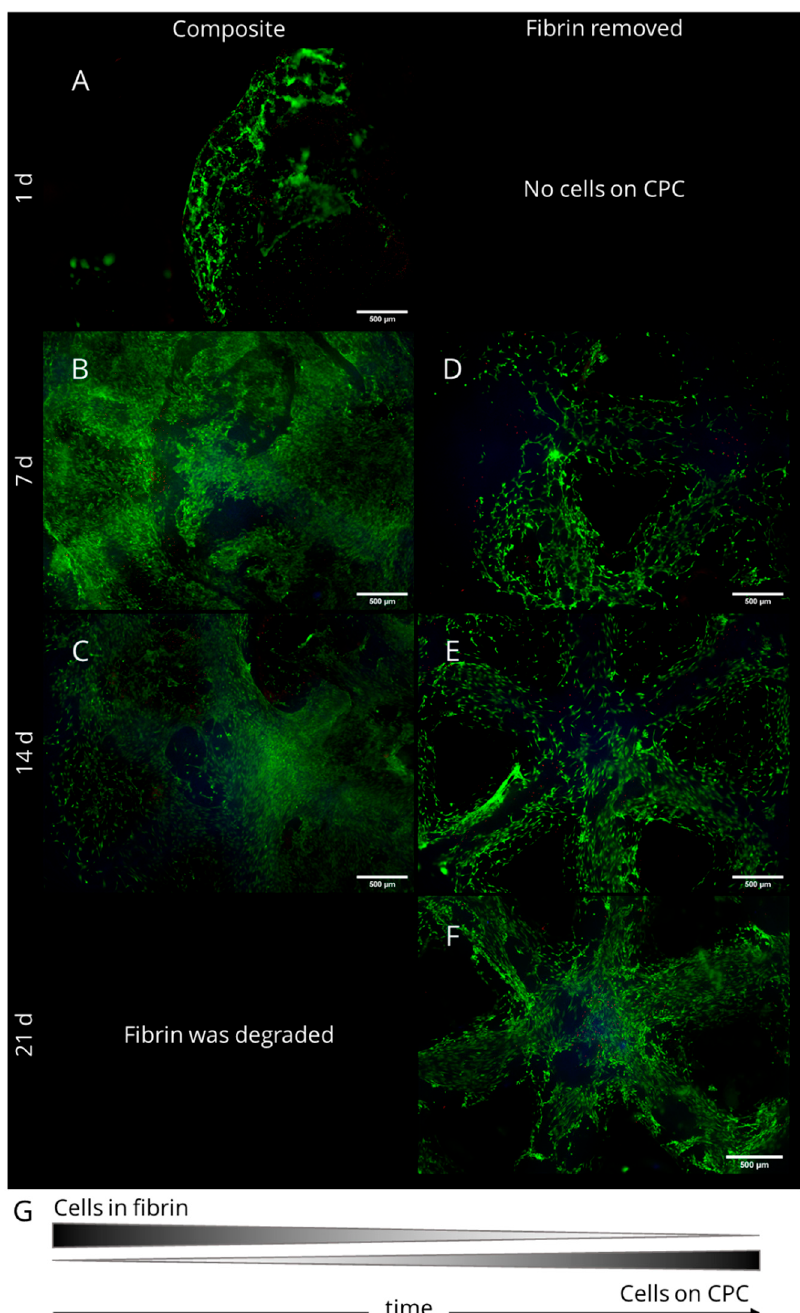
Figure 4. Fluorescence images of rMSC in biphasic CPC-fibrin scaffolds. Living cells are stained green, dead cells are stained red and CPC reveals a slight blue autofluorescence. With passing culture and fibrin degradation, the rMSC migrated onto the CPC surface. ( A ) after 1 day of cell cultivation on the composite scaffold; ( B ) after 7 days on the composite scaffold; ( C ) after 14 days on the composite scaffold; ( D ) after 7 days of cultivation and after removal of the fibrin; ( E ) after 14 days of cultivation and after removal of the fibrin; ( F ) after 21 days of cultivation and after removal of the fibrin. Scale bars represent 500 µm.